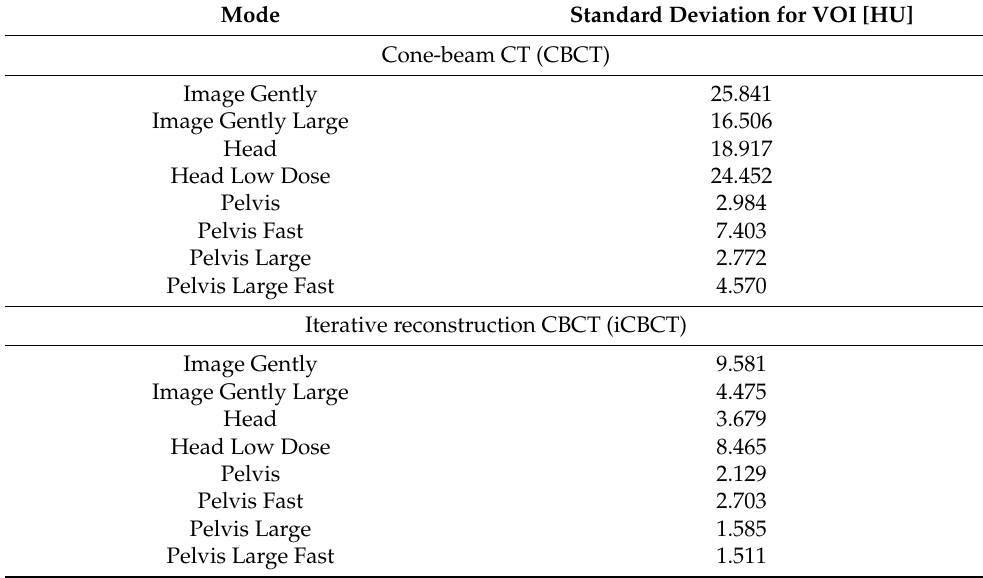
Table 3. Impact of reconstruction algorithms and modes on image uniformity for scanning PABIG nx in PH-5-DD1 GeVero Co. container with the Halcyon accelerator equipped with CBCT and iCBCT. VOI: 20 mm diameter, 20 mm height.